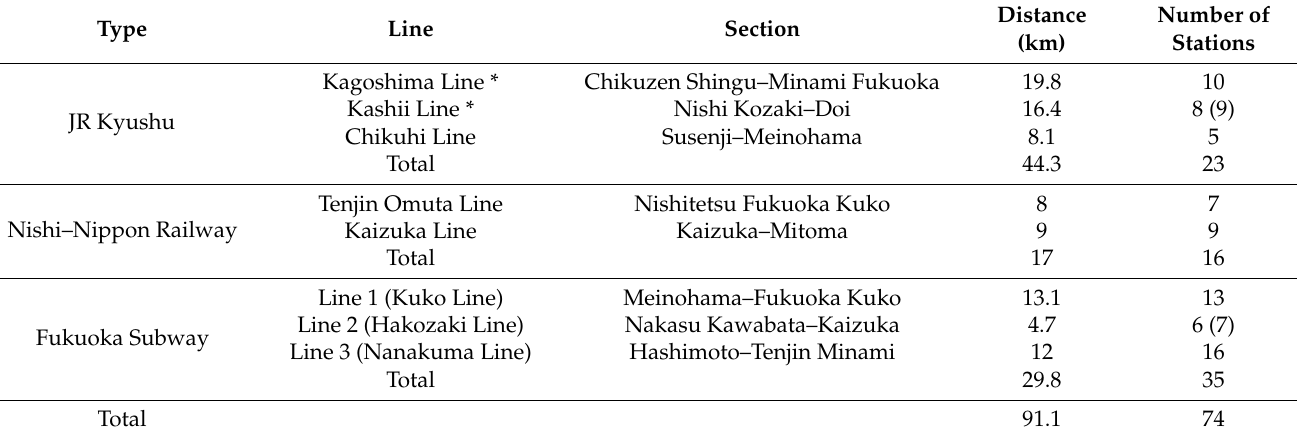
Table 2. Outline of railway lines and